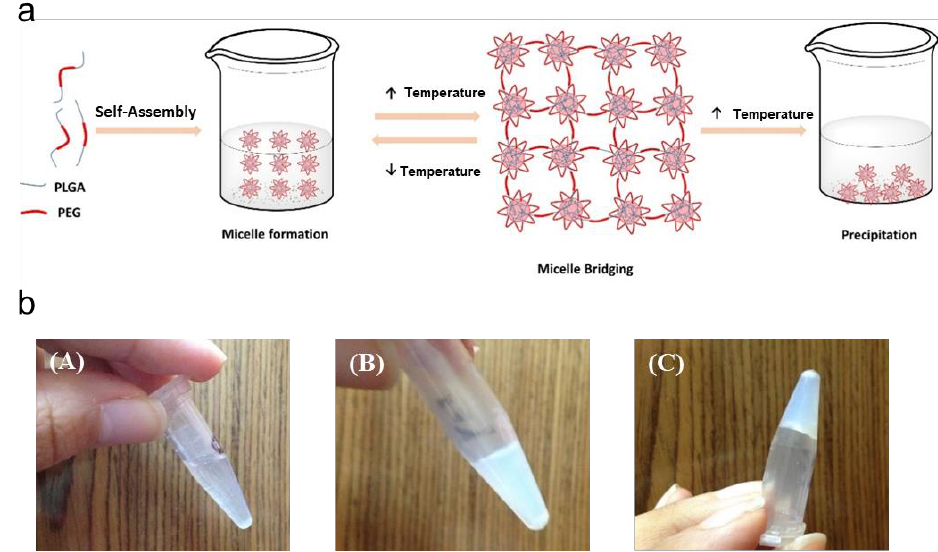
Figure 8. ( a ) Diagram of the sol – gel transition of BAB-type poly(lactic acid-co-glycolic acid)- poly(ethylene glycol)-poly(lactic acid-co-glycolic acid) (PLGA-PEG-PLGA) tri-block copolymer aqueous solution in response to temperature; ( b ) (A,B) are the photographs of a PLGA-PEG-PLGA copolymer solution prior to sol – gel transition (A) and formation of opaque solution (B), and thermogels produced after sol – gel transition retain their position (C) . Reprinted with permission from Ref. [111]. Copyright 2018, copyright with permission from El-Zaafarany and Soliman.